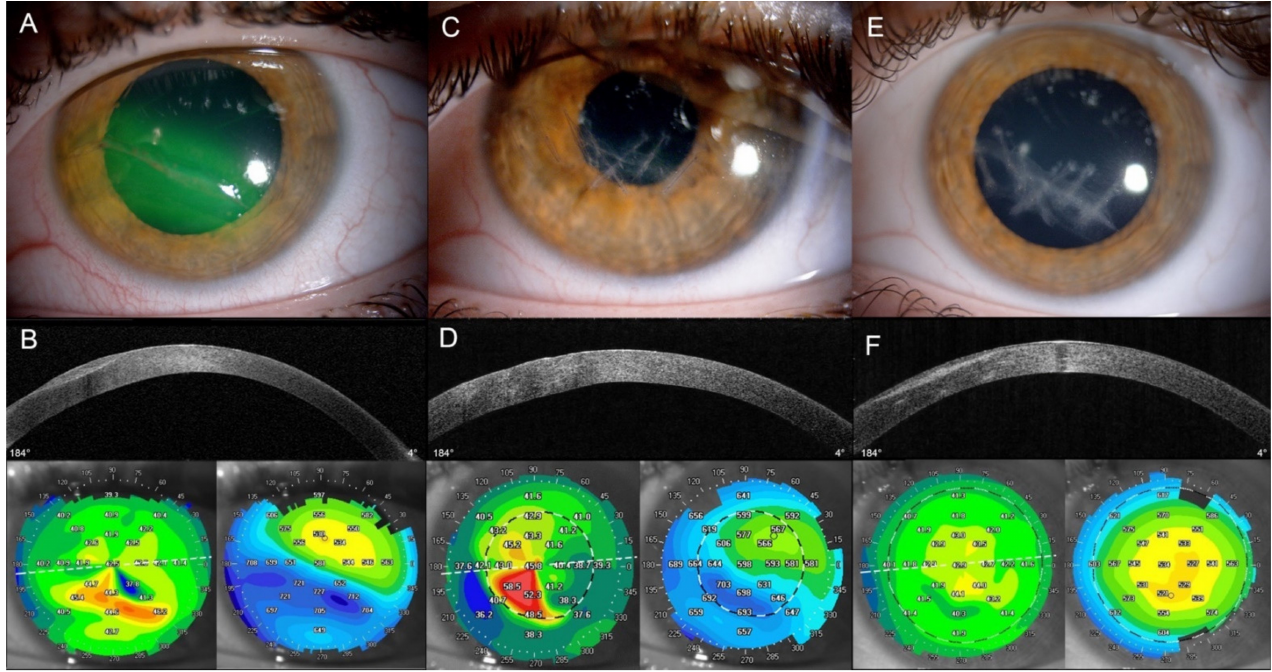
Figure 1. Non-penetrating corneal laceration caused by scissors, on a 12-year-old child. Multimodal imaging of the corneal wound. (( A , C , E ): Slit lamp images (Topcon). ( B , D , F ): Anterior segment OCT (AS-OCT), topography and pachymetry map (SS-OCT CASIA 2, Tomey) images). ( A , B ) Baseline examination showing a 9-mm spiroid linear laceration in zone 1 (OTC group), with some rust particles in the shredded stromal bed. B-scan showed wound spiroid wound interface (hyperreflective line), in the anterior third of the corneal thickness. Local variations occurred along the wound on topography (corneal astigmatism 2.3 diopters) and reactional stromal edema of the lower hemi-cornea (+100 to 150 µ m versus upper part) were highlighted on the pachymetry map. Maximum lamellar depth was 40% of total corneal thickness. Preoperative far visual acuity (VA) was 20/50 (0.4 logarithm of the minimal angle resolution (logMAR)) and near VA was Jaeger 7 (0.5 logMAR). ( C , D ) Postoperative result on Day 10, showing seven light-purple threads of polyglactin 910 (or V10-0), which spared the visual axis. Inferior hemi-cornea was clearer with normal conjunctiva, no local inflammation (surface or anterior chamber) was noted. Comparative B-scan showed anterior stromal hyperreflective lines corresponding to the treads. Moderate transient suture-induced astigmatism was visible on topogra- phy, and stromal edema reduced with a more homogeneous pachymetry map. ( E , F ) Mid-term result at Month 2, the wound has healed with a longitudinal opacity corresponding to the initial wound interface. No more threads were present. A mild loss of transparency was present along the initial threads path due to suture absorption. Comparative B-scan showed longitudinal anterior stromal hyperreflectivity corresponding to the initial spiroid flap with secondary reorganized keratocytes, and the suture path was still visible more posterior transversely (small hyperreflective lines with a mild condensation of the posterior stroma). There was no residual surgically induced astigmatism (1.3 diopters, similar to the contralateral healthy eye). Pachymetry map was homogeneous and had a normal profile. Postoperative far VA was 20/25 (0.1 logMAR) and near VA was Jaeger 2 (0.2 logMAR). Complete V10-0 sutures absorption was achieved in all eyes at M2 without compli- cation, especially with no neovascularization, inflammation, allergy, or loosening of the knot. All corneal wound interfaces presented a relative loss of transparency. No adverse events occurred, particularly infectious (abscesses or endophthalmitis), nor was any addi- tional surgery needed. Compared to baseline, no significant IOP variation was observed at D10 ( p = 0.067), M2 ( p = 0.342), M6 ( p = 0.431), or M12 ( p = 0.109). Specular endothelial cell density did not change significantly between D10 (3068 ± 520 cell/mm 2 ) and M12 (2944 ± 568 cell/mm 2 ) ( p =